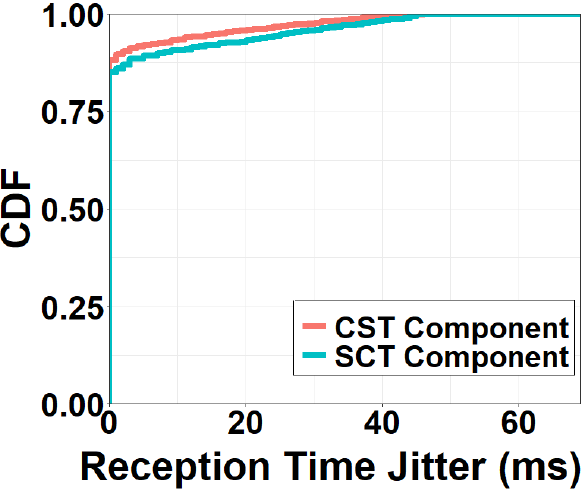
Figure 12. Jitter of packet reception